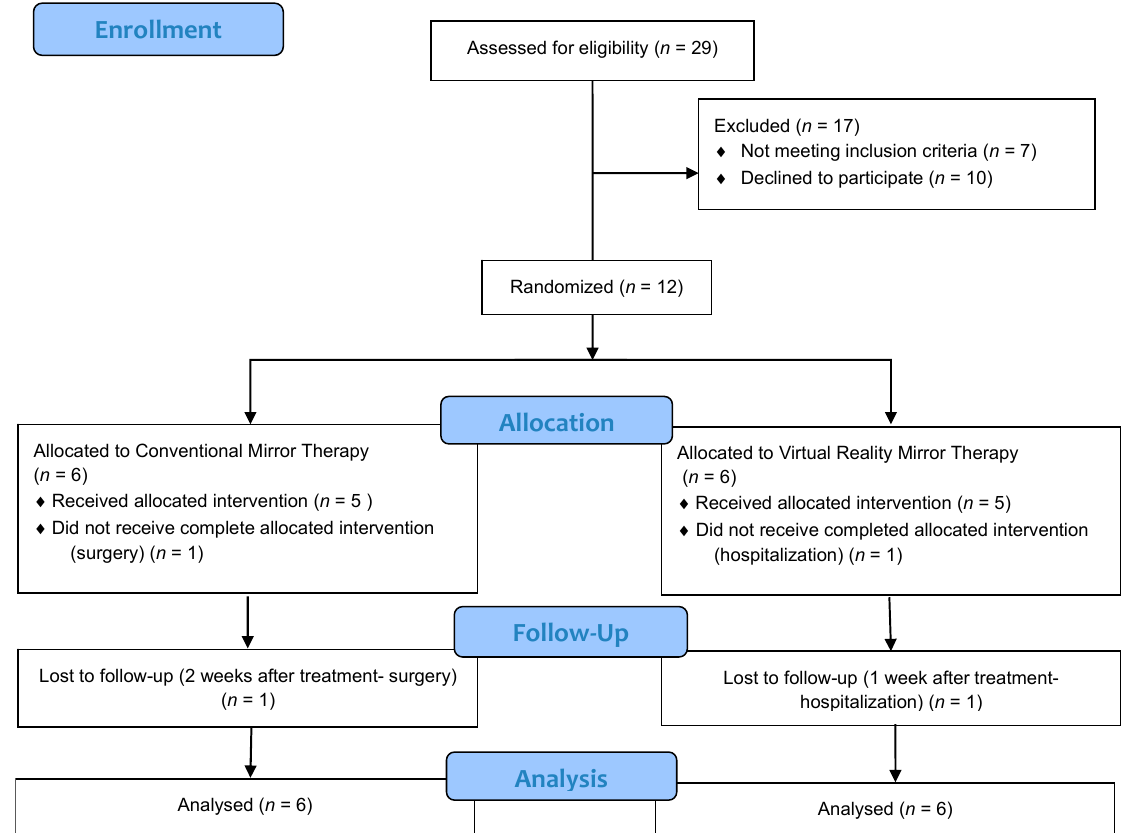
Figure 3. Consort flowchart.